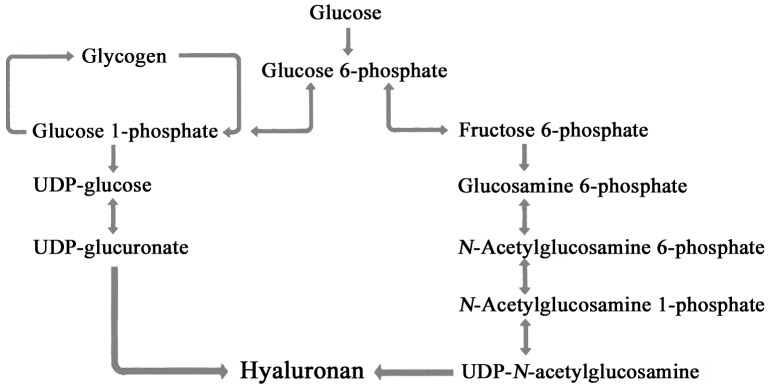
Hyaluronan pathway.